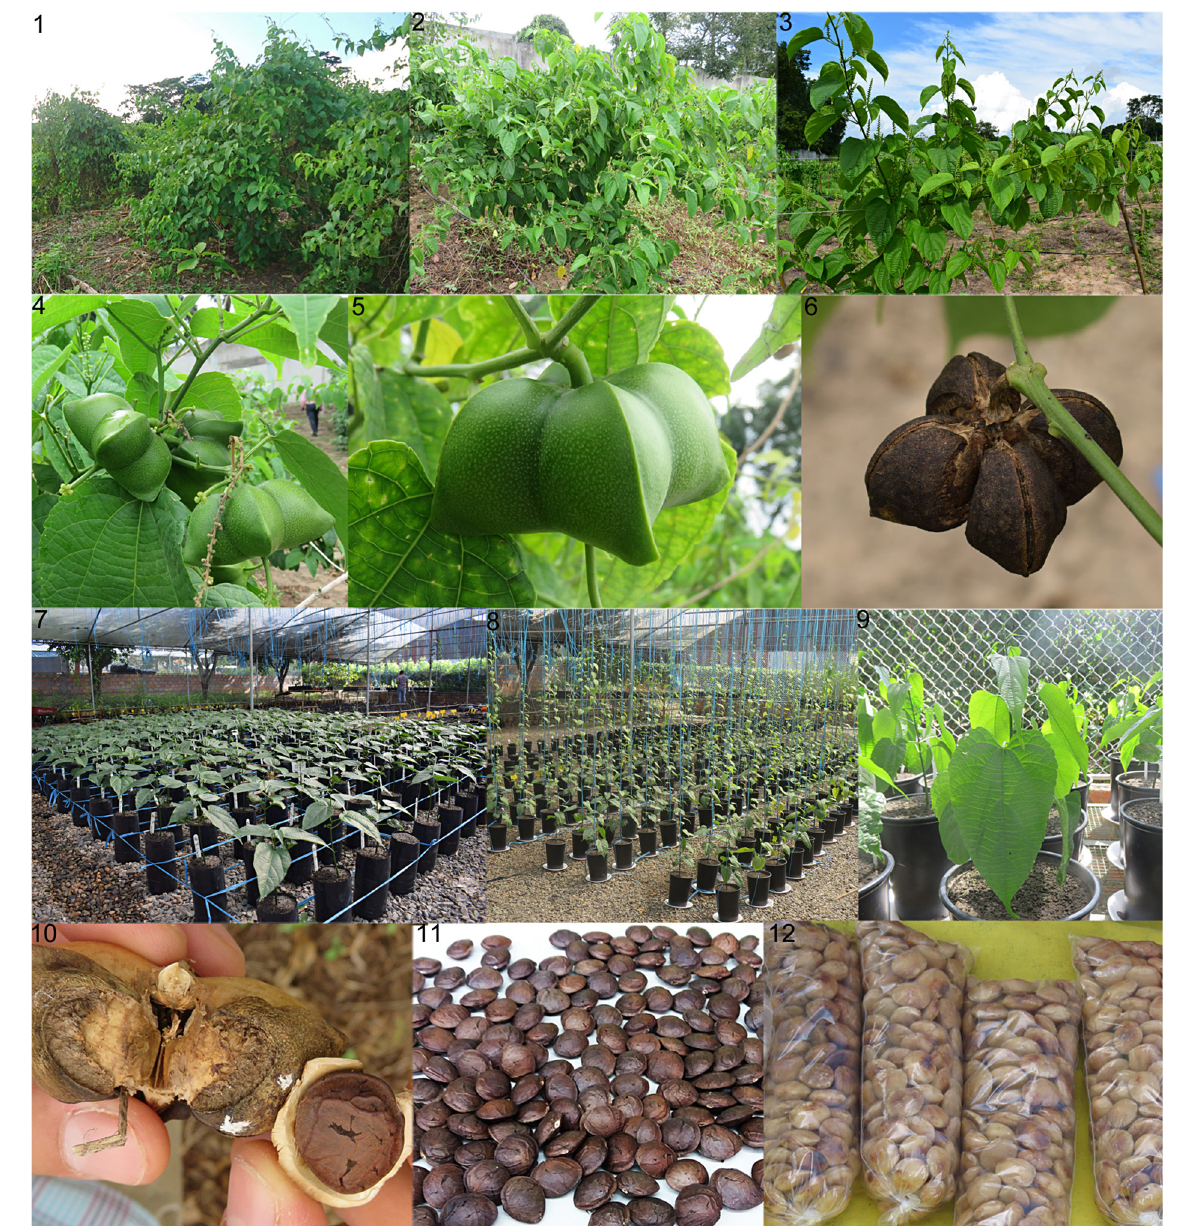
Figs. 1-12 Plukenetia volubilis : 1. Inka nut plantation at the type location in Palmiche (province Lamas, San Martín, Peru). The annual agricultural crops maize, peanuts and beans planted in the inter-rows had already been harvested at sampling time. 2-3. Inka nut plants grown at the University of San Martín in Tarapoto. The inka nut plantations in San Martín State last for 4-5 years in the same field and can be replaced by new plantations or other field crops. 4-6. Inka nut capsule fruits in different ripening stages. 7-9. Inka nut plants in different development stages, grown in the greenhouse of the University San Martín in Tarapoto. Inka nut is a semi-woody, climbing plant and need support for vertical growth at early stages, either abiotically or by living plants. 10. Decapsulation of a seed. 11. Dark brown, field collected seeds, each 1-2 cm in diam. 12. Toasted almonds of the inka nut, photographed at a local market in